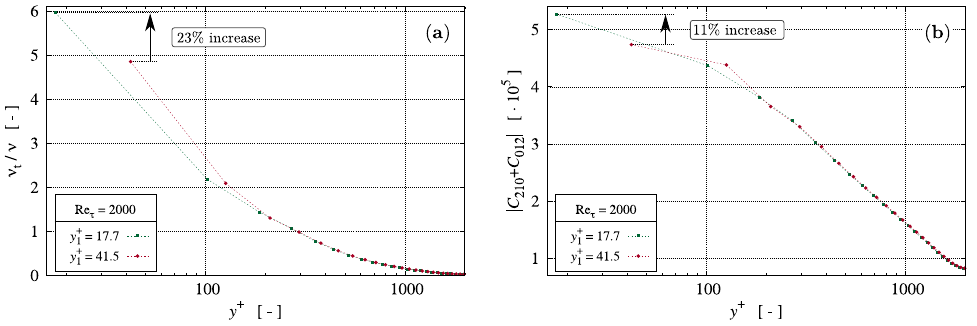
Figure 5. ( a ) Increase in the normalized (averaged) eddy viscosity and ( b ) the related (averaged) cumulant expression at the first fluid node in response to a shift in the wall position computed from Equation (10) for Re τ = 2000 and ∆ x + = 83 ( N H = 24).